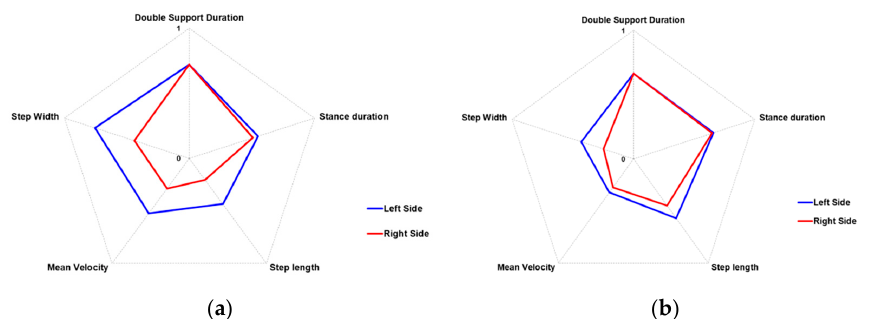
Figure 5. Radar charts of the relevant gait parameters for the left and right sides of the PD ( a ) and PS ( b ) performance.